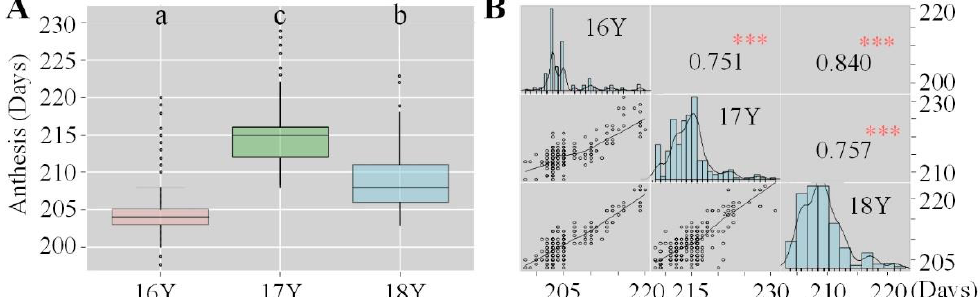
Figure 4. Boxplot and correlation matrix of the anthesis days of 100 wheat varieties evaluated in three growing seasons: ( A ) boxplot of the anthesis of 100 wheat varieties evaluated in three growing seasons; ( B ) correlation matrix of the anthesis of 100 wheat varieties evaluated in three growing seasons. 16Y, 2016–2017 growing season; 17Y, 2017–2018 growing season; 18Y, 2018–2019 growing season. The different letters (a, b, and c) represent significance at the 0.05 level. *** Significant at the 0.001 level; ** significant at the 0.01 level; * significant at the 0.05 level.